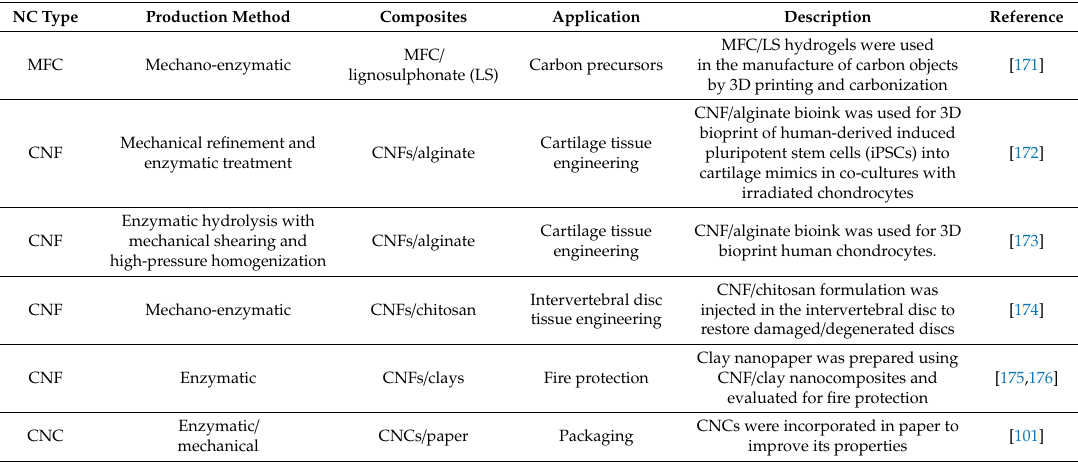
Table 4. Application of nanocellulose in di ff erent